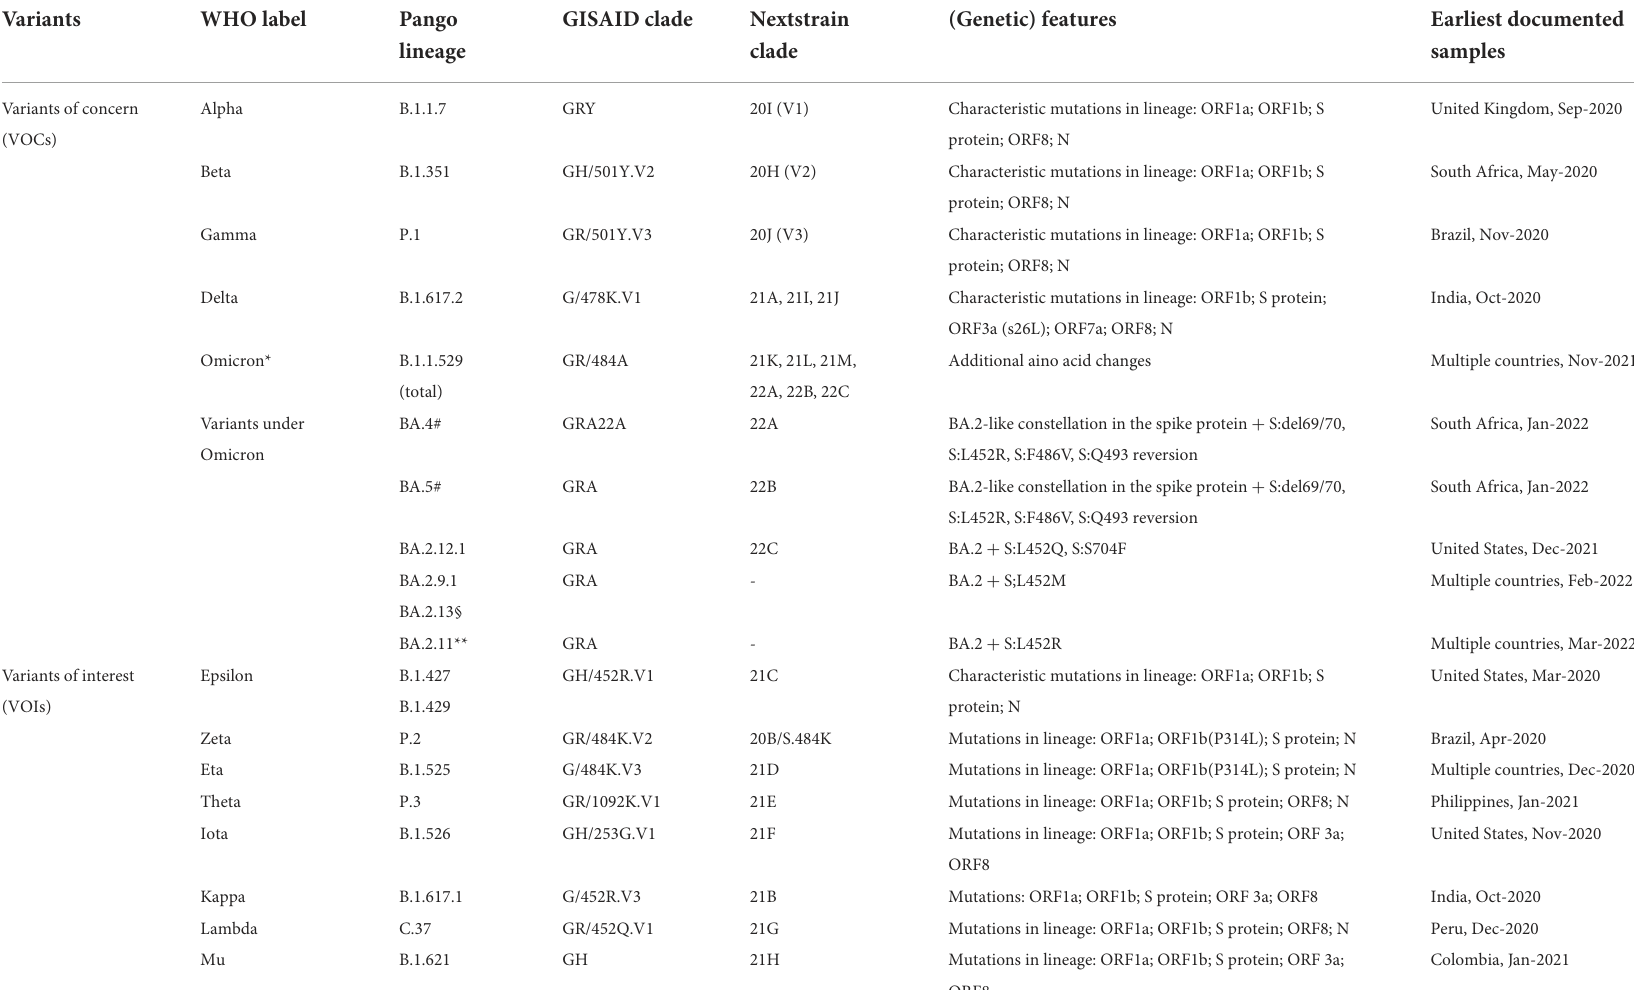
TABLE 7 Classifications and characterizations of current SARS-CoV-2